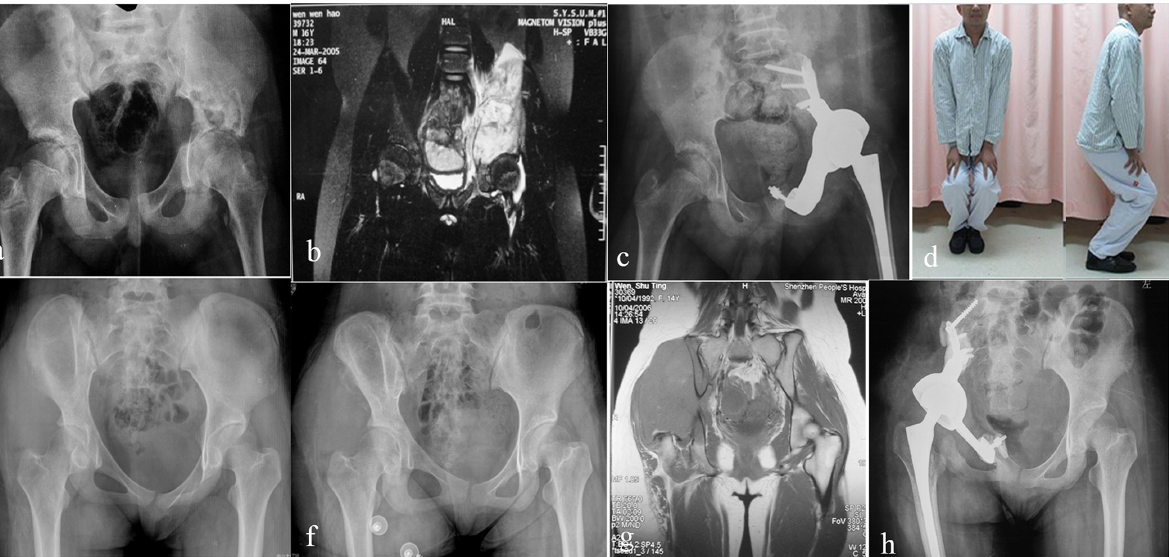
Fig 5. Patients follow-up. (a) and (b) Preoperative X-ray film and MRI of a patient with osteosarcoma involving section I/II of the left hemipelvis. (c) Postoperative X-ray film showing reconstruction with the modular hemipelvic endoprosthesis. (d) The function status of the hip joint of the same patient after reconstruction showing favorable extent of hip flexion. (e) Preoperative X-ray film of a patient with osteosarcoma involving section I/II of the right hemipelvis. (f) X-ray film after neo-adjuvant chemotherapy showing significantly enhanced osteogenesis inside the tumor. (g) Preoperative MRI. (h) Postoperative X-ray film showing reconstruction with the modular hemipelvic